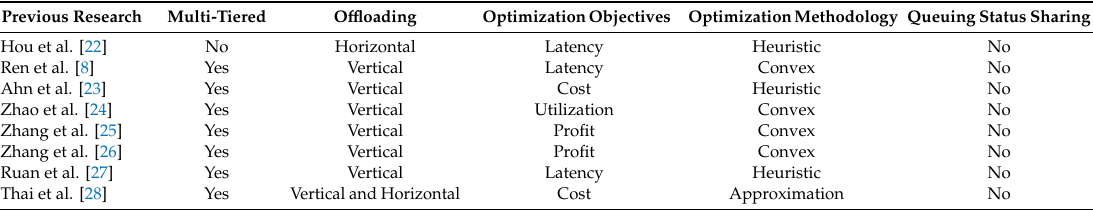
Table 1. Published works on o ffl oading optimization between